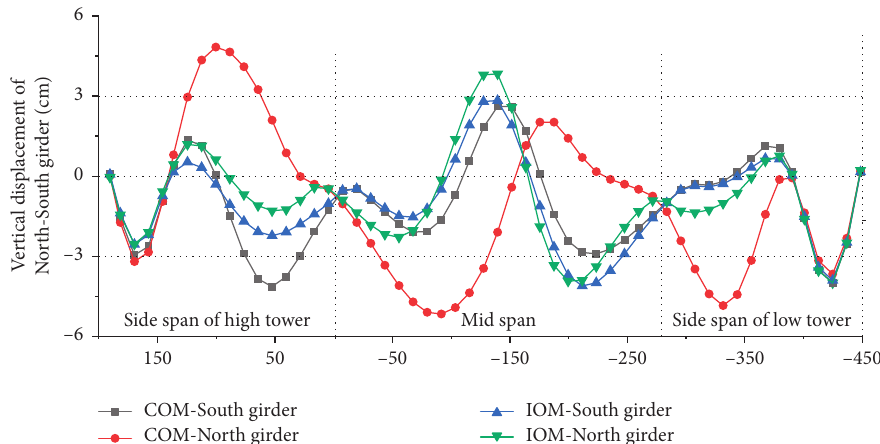
Figure 13: Comparison of vertical displacement between main girders.